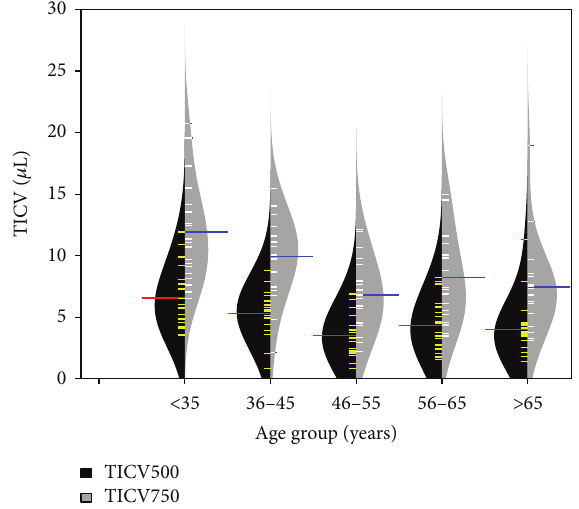
(5.7%) were excluded due to poor image quality, leaving a total of 100 eyes included in the study. Of those, 61% (61 eyes) were women. The mean ( ± SD) age was 50 ( ± 15) years (range 20–79 years). Forty-three (43%) were right eyes. The